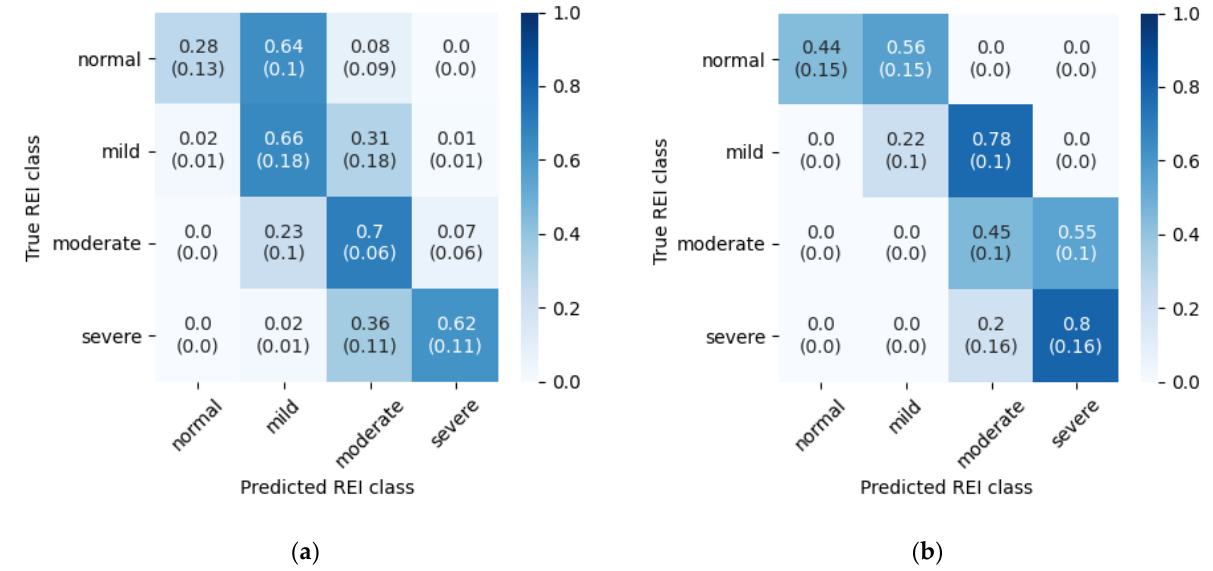
Figure 9. Row-normalized REI classification confusion matrix with “Wake” periods removed. ( a ) Test set from SHHS-1 database; ( b ) PhysioNet Sleep Database. Table 6. Mean error, standard deviation, min and max errors, Pearson’s and Spearman’s correlation coefficients for REI, HI and AI with “Wake” periods removed. The values were averaged across five experiment iterations. Data obtained on SHHS-1/PhysioNet databases.